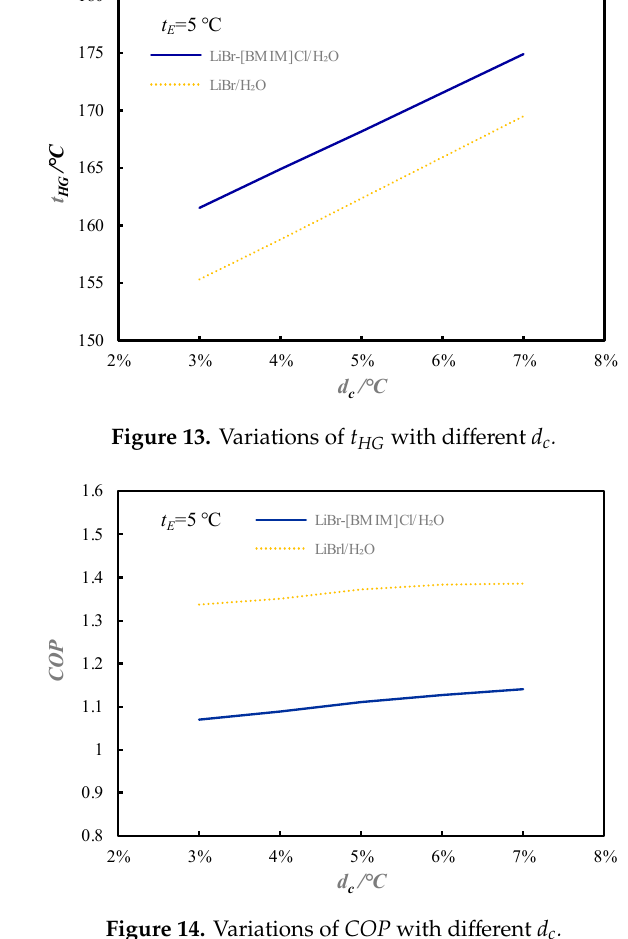
Figure 14. Variations of COP with di ff erent d c .